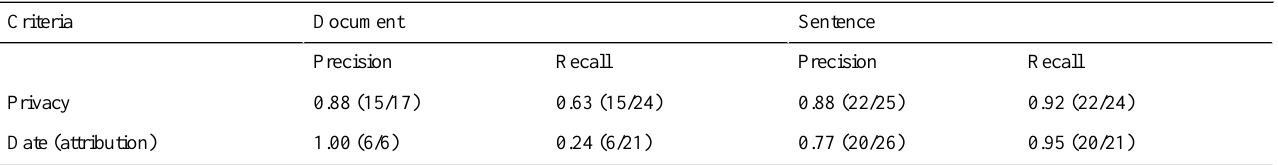
Table 4. Precision and recall of document and sentence automated HONcode detection.